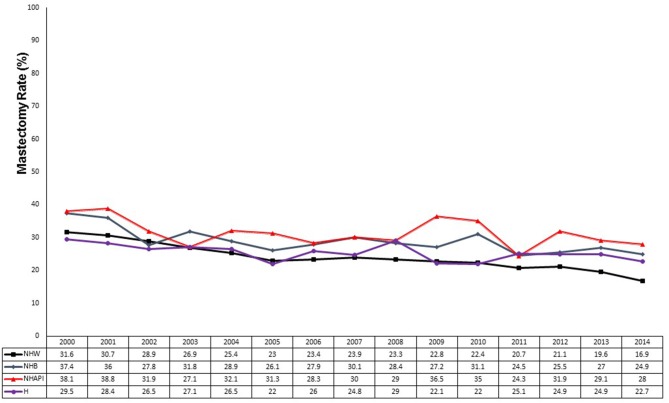
Mastectomy rates by race from 2000 to 2014. Black line, non-Hispanic Whites (NHW); blue line, non-Hispanic Blacks (NHB); red line, non-Hispanic Asian-Pacific Islanders (NHAPI); purple line, Hispanics.